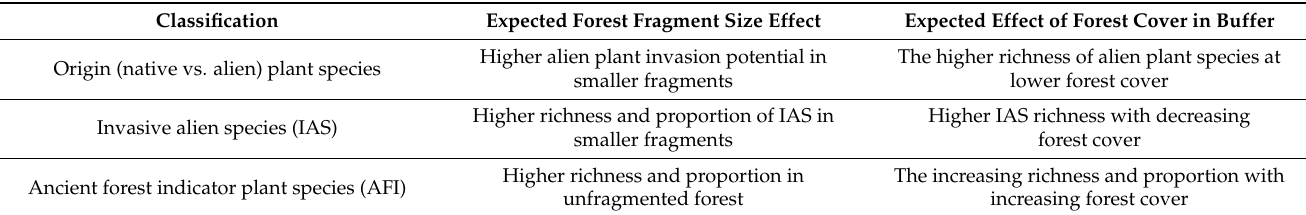
Table 5. Classification of forest vegetation based on three species’ characteristics: origin, invasiveness, and ancient forest indicator plants sensu Hermy et al.